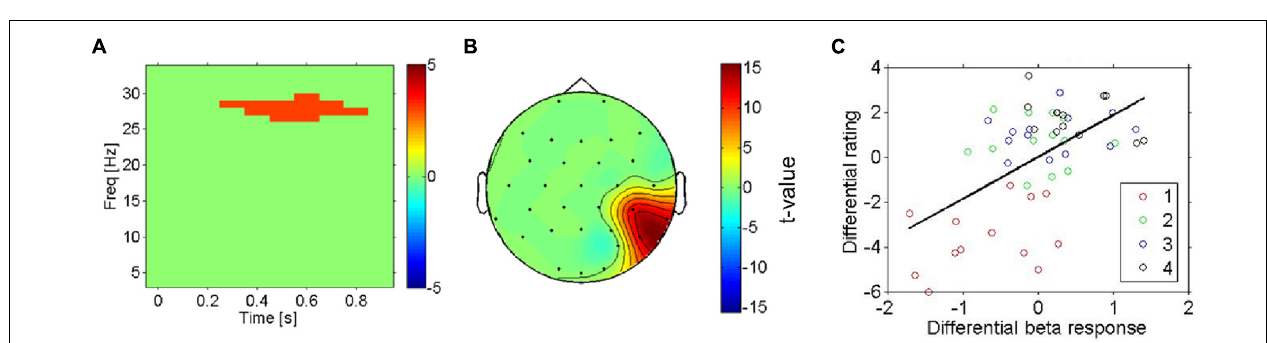
FIGURE 3 | Right hemisphere beta-oscillations distinguish most pleasant from least pleasant sensations. (A) Time-frequency- representation of the contrast between the most and least preferred fabric conditions shown for the significant cluster in right temporo-parietal electrodes. The rectangle indicates the time-frequency window that the cluster-analysis showed as significant. (B) Topographical result for the